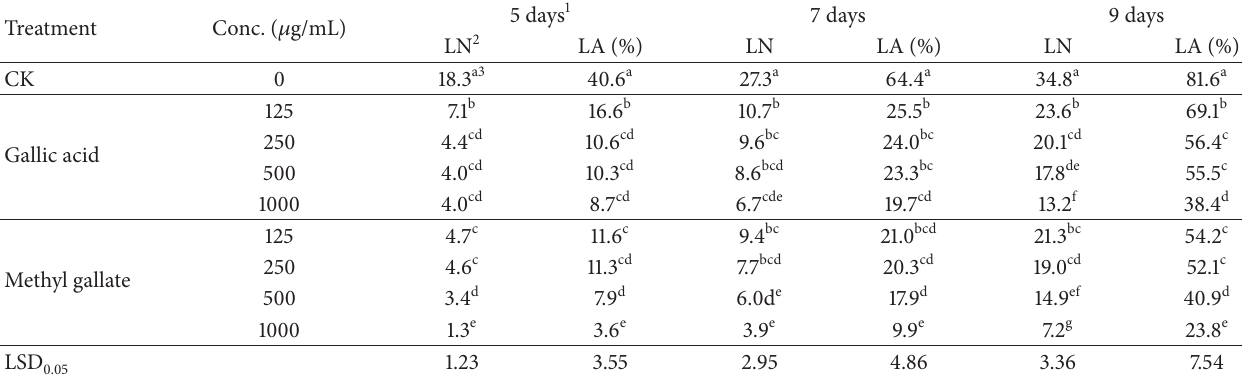
Table 6: Effect of gallic acid and methyl gallate on control of anthracnose disease of Chinese cabbage caused by Colletotrichum higginsianum PA-01 in growth chamber.